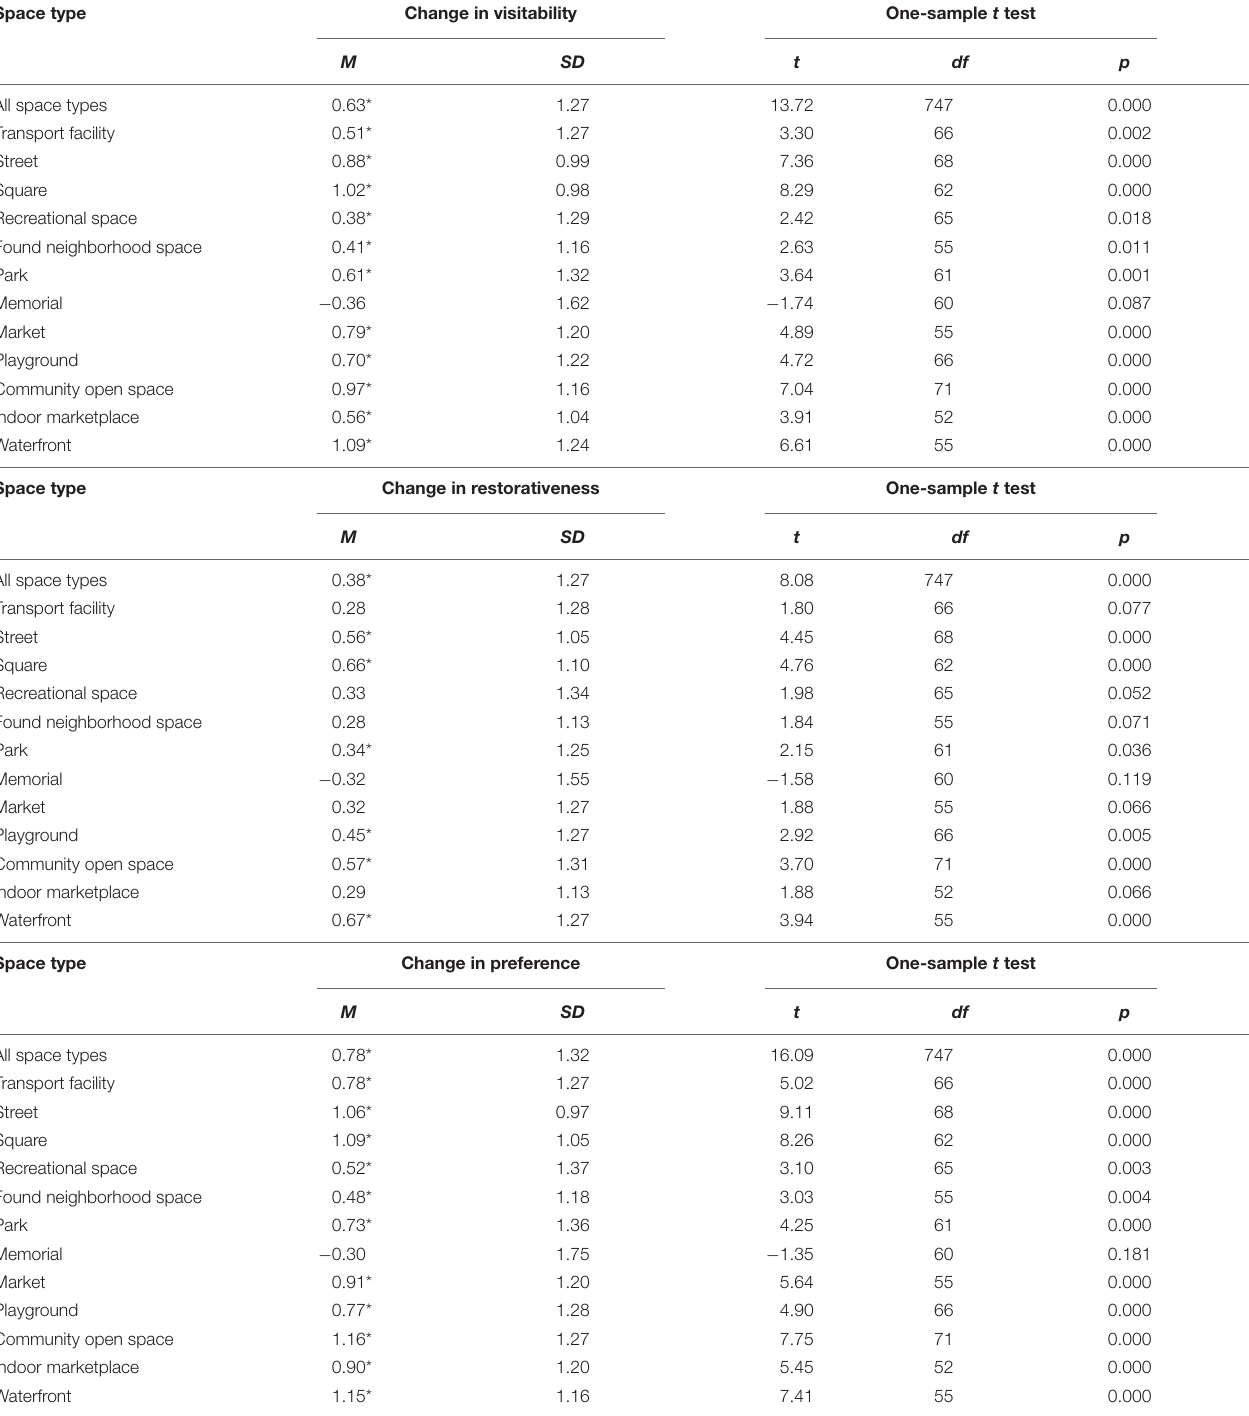
TABLE 5 | Data from Study 1: Mean changes in visitability, restorativeness, and preference of public space as a function of street performance. Space